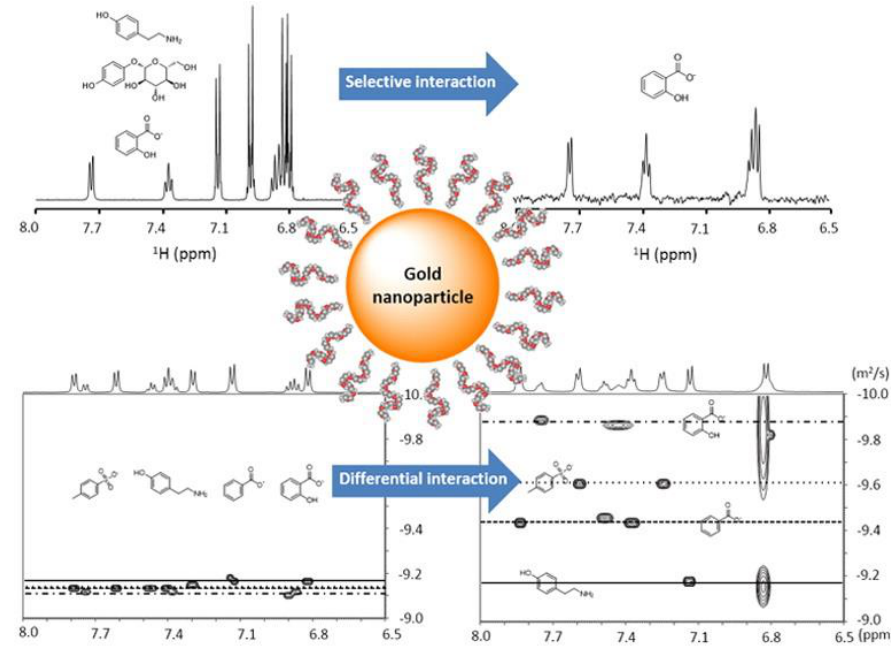
Figure 4. Application of nanoparticles with different surface modifications for selective molecular